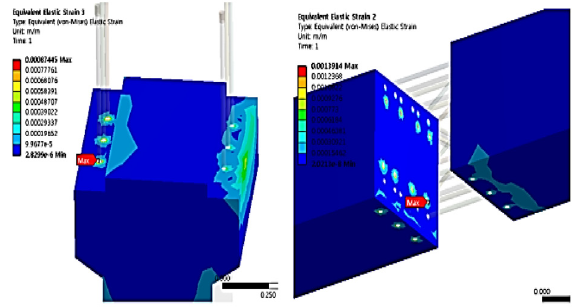
Fig. 27. Strain in PC beam-column interface at an eccentric load of 136 kN